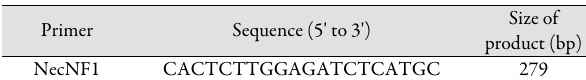
Table 1. PCR primer designed for specific detection of the nec1 gene of pathogenic Streptomyces